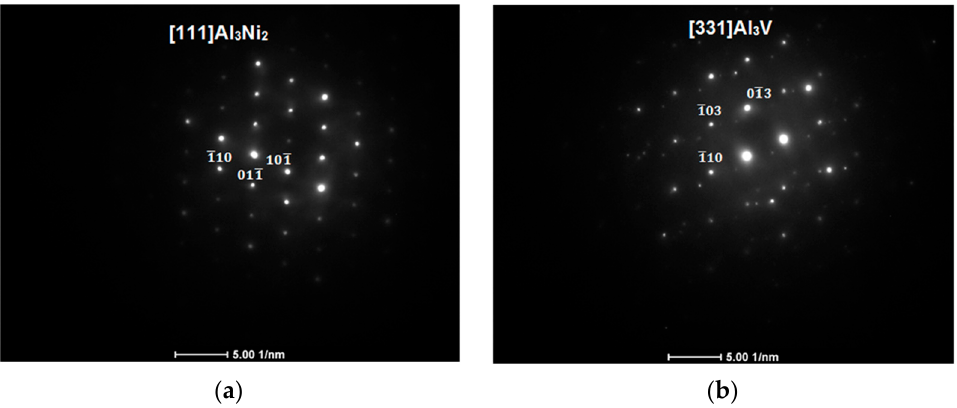
Figure 9. SAD patterns of thin films deposited onto W wires after ignition. ( a ) Grain phase and ( b )